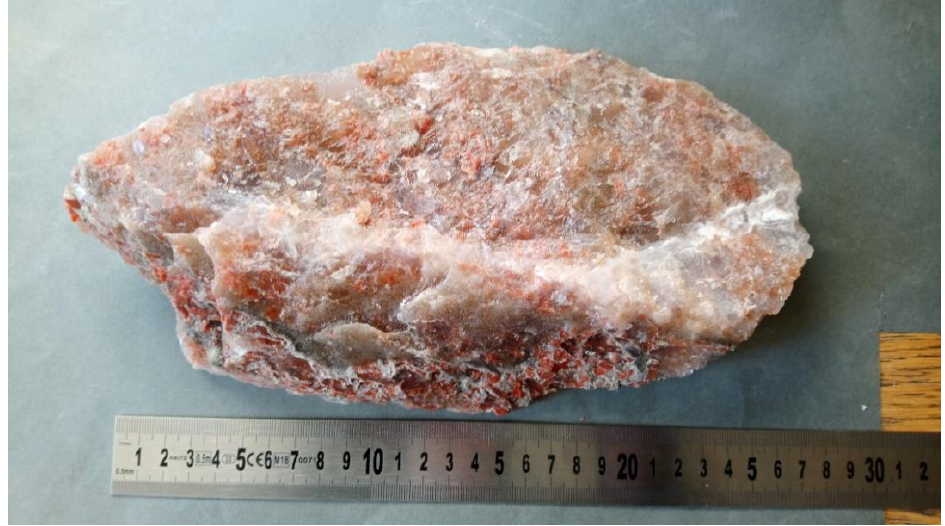
Figure 4. Sample of kieseritic salt from the Older Potash (K2) unit. The Z-2/1 section in the gallery of salt mine KŁODAWA S.A., Kłodawa salt dome.